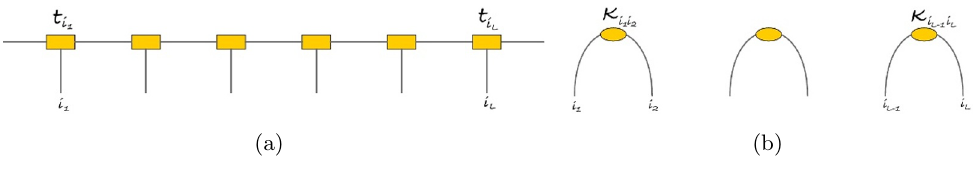
Figure 2 . Two types of integrable boundary states: (a) MPS (b)